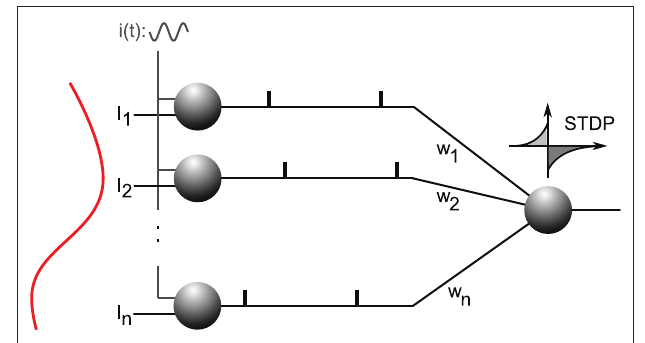
Figure 5 | Neural architecture. Excitatory afferent neurons 1, … , n (on the left) receive individual input currents I , … , I plus a common oscillatory drive 1 n i ( t ), which leads to a current-to-phase conversion: the stronger the current the earlier a neuron fires during an oscillation cycle. Afferents project with plastic weights w , … , w to one downstream neuron equipped with STDP. This 1 n neuron will gradually become selective to the spike wave corresponding to the repeating current pattern. Figure adapted from Masquelier et al.